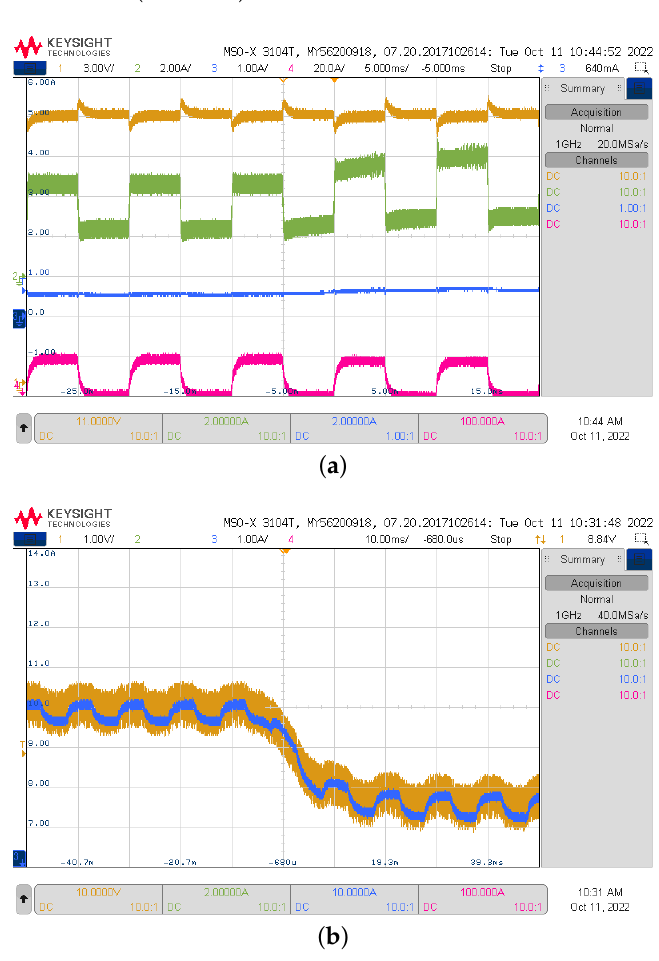
Figure 6. Dynamic response of the proposed controller: ( a ) Experimental results for the boost converter when the CPL is a 100 Hz square waveform between 20 and 40 W, with a duty cycle of 0.5. CH1: x 2 (3 V/div), CH2: x 1 (2 A/div), CH3: u (1/div), CH4: ˆ P (20 W/div), and time base of 5ms. ( b ) Input voltage changes from 10 V to 8 V. CH1: (1 V/div), CH2: (1 V/div), and time base of